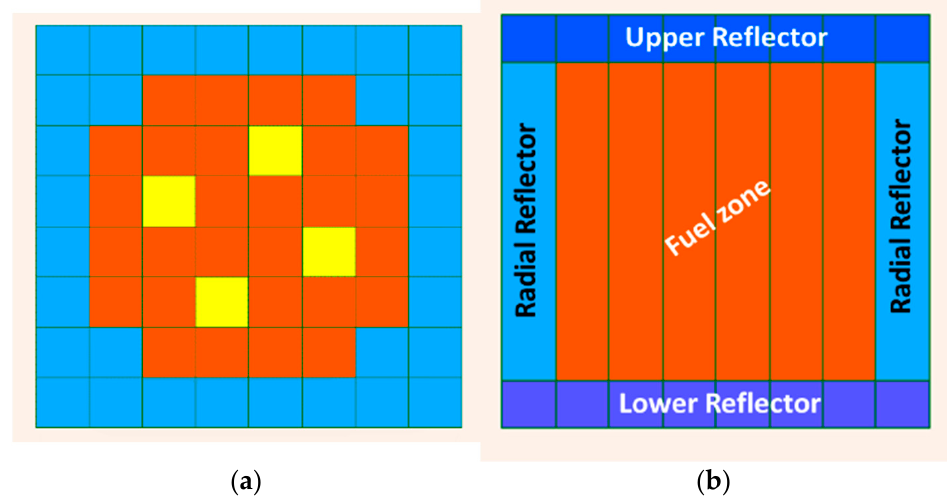
Figure 2. 32 FA PWR minicore layout. Simplified scheme: ( a ) radial configuration; ( b ) axial configuration.